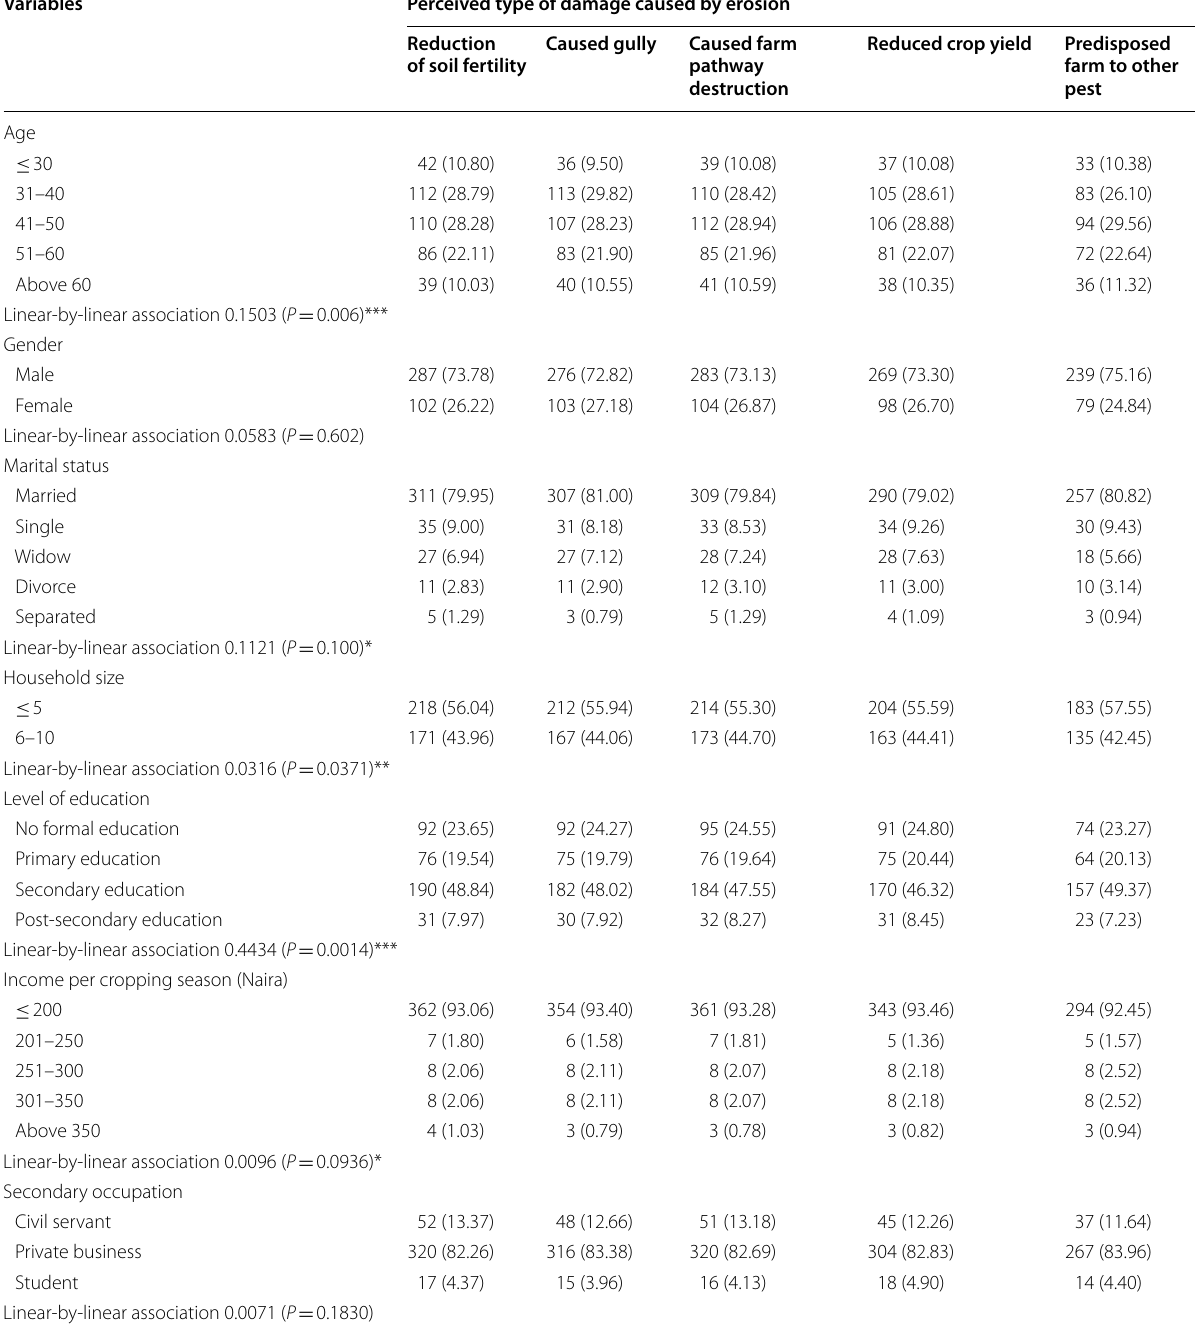
Table 7 Farmers’ perception of the major type of damage caused by erosion on crops on farmland. Source : Field